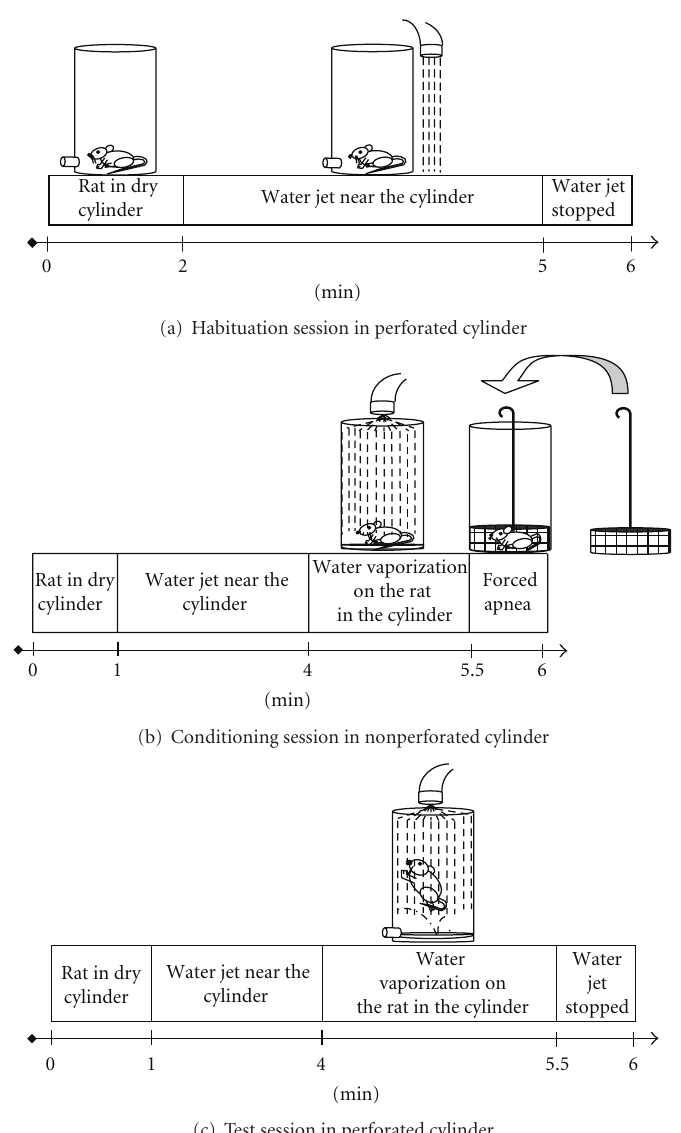
Figure 1: Schematic representation of the procedure used for assessment of behavioral responses. (a) Habituation session in perforated cylinder. (b) Conditioning session in nonperforated cylinder. (c) Test session in perforated